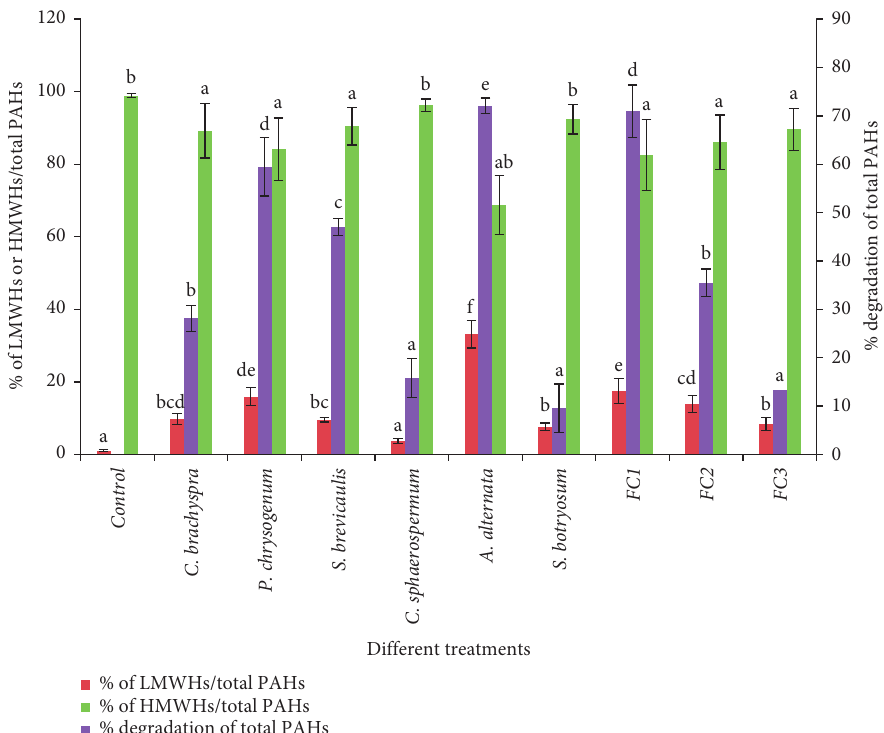
Figure 5: Quantitative degradation estimated by HPLC, of % LMWHs/total PAHs, % HMWHs/total PAHs, and % degradation of total PAHs using pure and mixed fungal cultures. SE is presented as a vertical bar above each mean. The same letters indicate that there is no significant difference in % of LMWHs and HMWHs/total PAHs and % degradation of PAHs in samples treated with different pure and mixed fungal cultures regarding Duncan’s multiple range tests at P < 0.05. FC1 = mixed culture of Penicillium chrysogenum and Curvularia brachyspora , FC2 = mixed culture of Scopulariopsis brevicaulis and Stemphylium botryosum , and FC3 = mixed culture of Scopulariopsis brevicaulis , Stemphylium botryosum, and Cladosporium sphaerospermum .